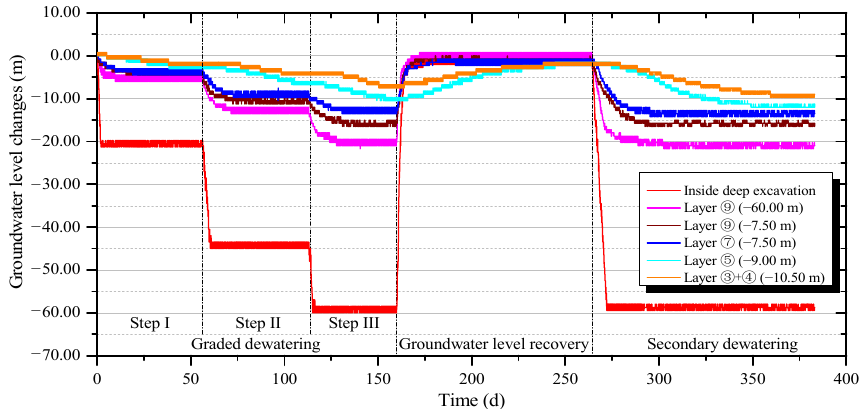
Figure 4. Groundwater level changes in strata at JF–1 (15.0 m away from deep excavation).